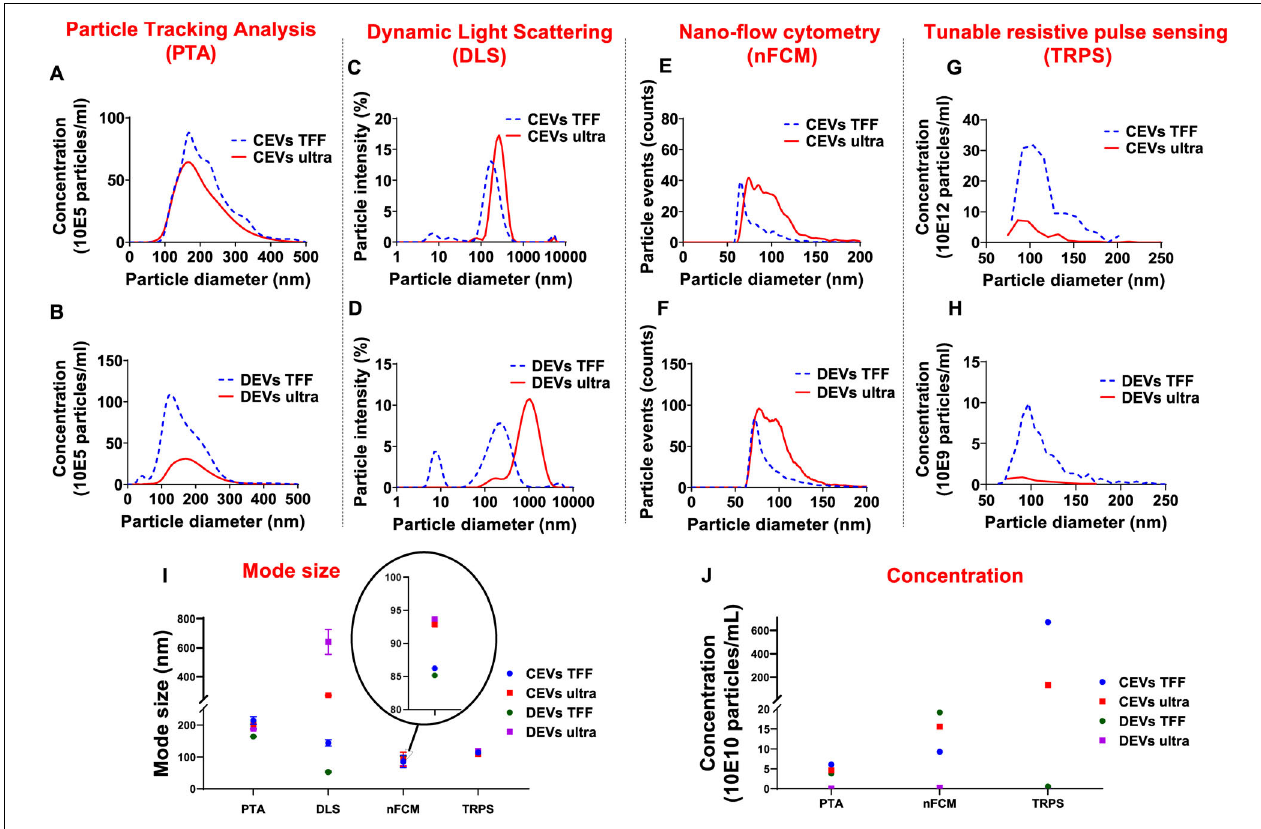
FIGURE 1 | Comparison of the size distribution for different isolated extracellular vesicles (EVs). Representative histograms revealing size distribution of extracellular vesicles derived from chorionic mesenchymal stromal/stem cell (CEVs) and extracellular vesicles derived from decidual mesenchymal stromal/stem cell (DEVs) isolated using tangential flow filtration (TFF) and ultracentrifugation by four different methods. The size distributions of these EVs were assessed by (A,B) particle tracking analysis (PTA), (C,D) dynamic light scattering (DLS), (E,F) nano-flow cytometry (nFCM), and (G,H) tunable resistive pulse sensing ( TRPS), respectively. The mode size (I) and concentration (J) of all EV samples were presented. The graphs represent the averaged values based on three repeated measurements of each EV